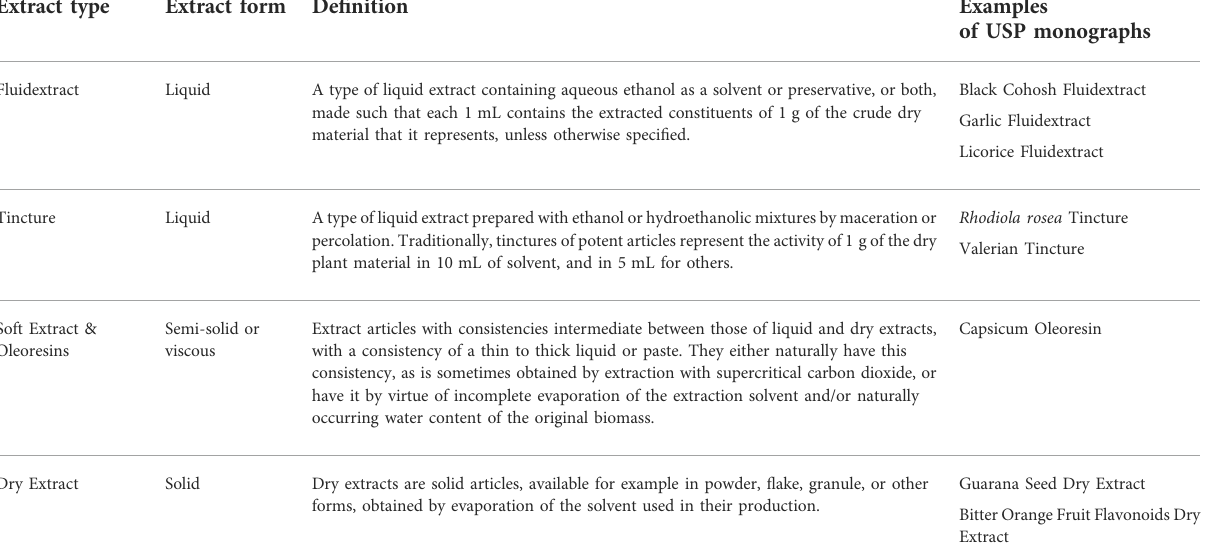
TABLE 1 Botanical extract types and